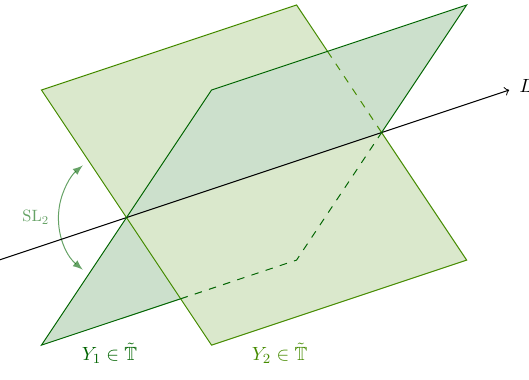
Figure 3 . Ambitwistor space parametrized by a pair of twistors Y ˙ a of opposite chirality. planes corresponding to two supertwistors Z 1 and Z 2 intersect iff Z 1 · Z 2 = 0 . They then intersect along a null super-geodesic C 1 | 4 N with tangent vector ( P